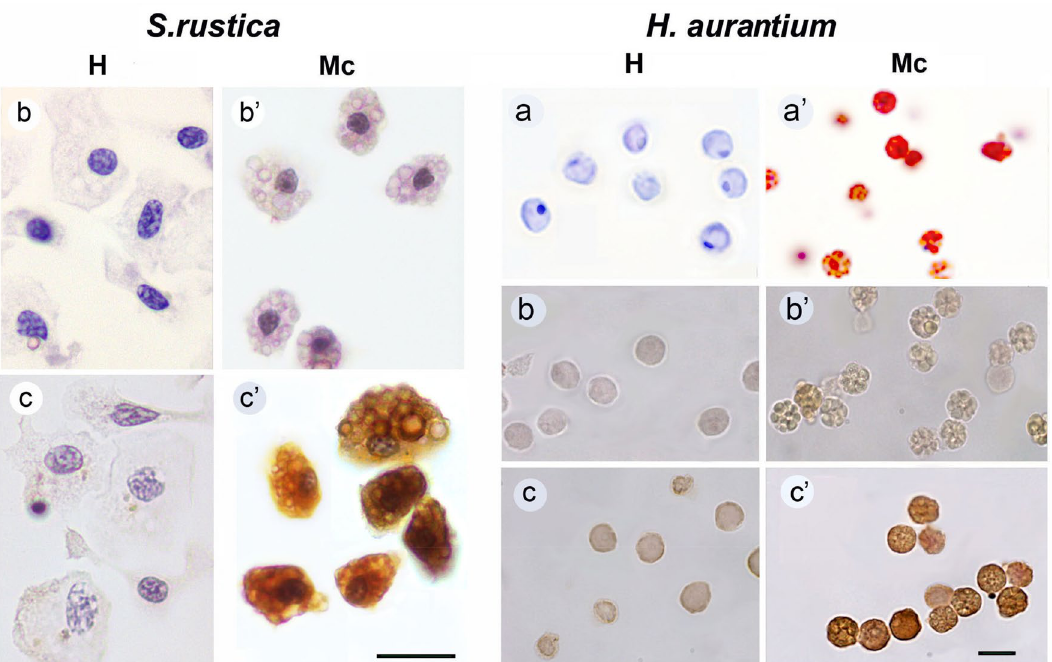
Figure 1. Cell fractions of hyalinocytes (H) and morula cells (Mc) of S. rustica and H. aurantium. ( a , a ′ ) H. aurantium cells stained with hematoxylin and eosin; ( b , b ′ ) S. rustica and H. aurantium cells, immunostaining without AB to p48 (control); ( c , c ′ ) S. rustica and H. aurantium cells, immunostaining with AB to p48. All S. rustica cells are additionally stained with hematoxylin. Scale bar—10 µm.